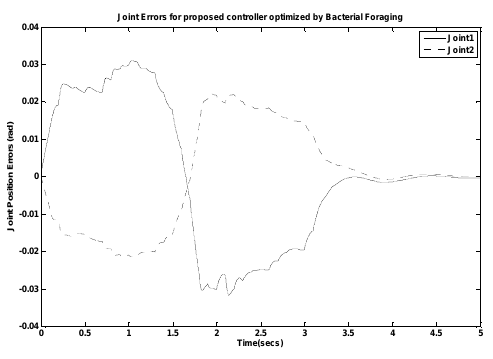
Fig. 9. Error profiles for the two joints using BFFPPDC.